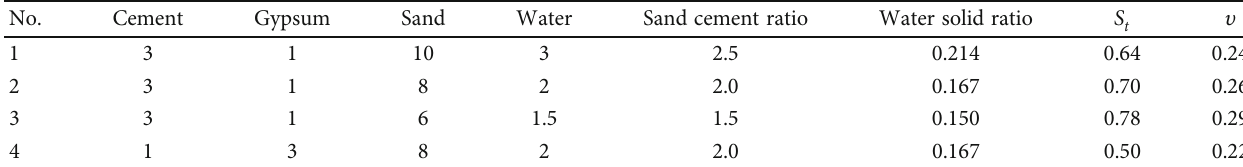
Table 4: Material ratio and mechanical